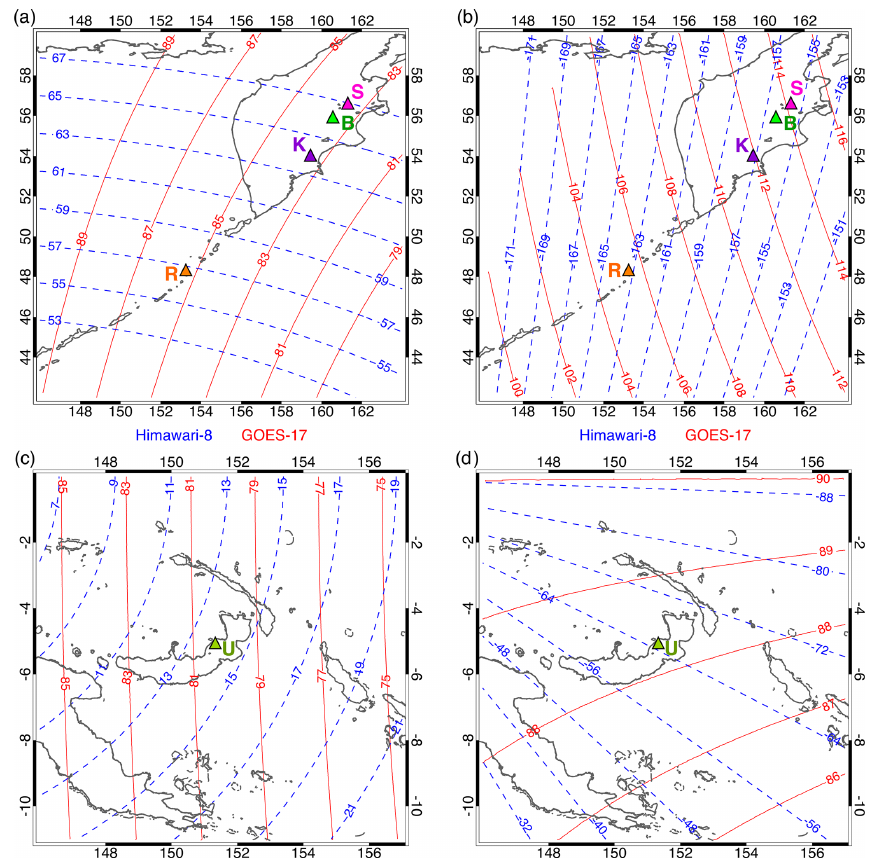
Figure 1. GOES-17 (solid red) and Himawari-8 (dashed blue) view geometry for our case study volcanoes (triangles). View zenith angle for (a) Sheveluch (S), Bezymianny (B), Karymsky (K), and Raikoke (R), as well as (c) Ulawun (U). The corresponding view azimuth angle measured clockwise from north ( + ) for GOES-17 and counterclockwise from north ( − ) for Himawari-8 is given in panels (b) and (d)